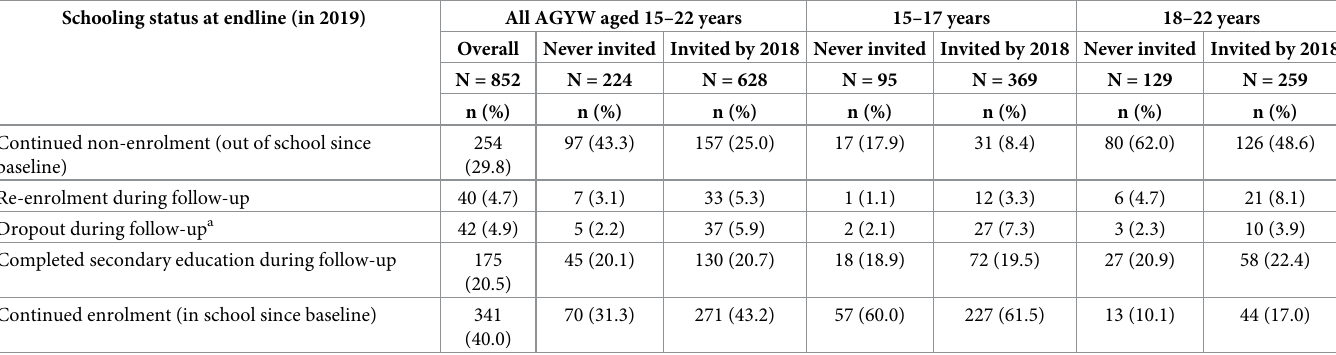
Table 3. Educational status at endline among AGYW aged 15–22 years at cohort enrolment in 2017, by invitation to